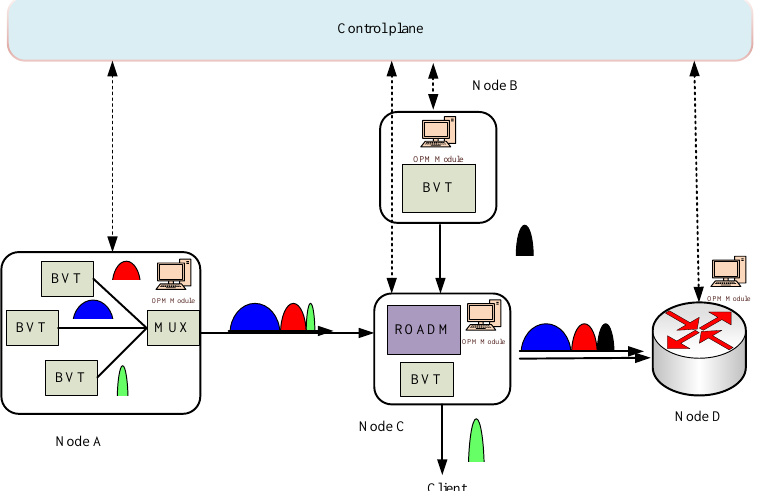
Figure 1. Basic principle of OPM in next generation EONs. Here, BVT is the bandwidth-variable transponder and ROADM is reconfigurable optical add/drop multiplexers.